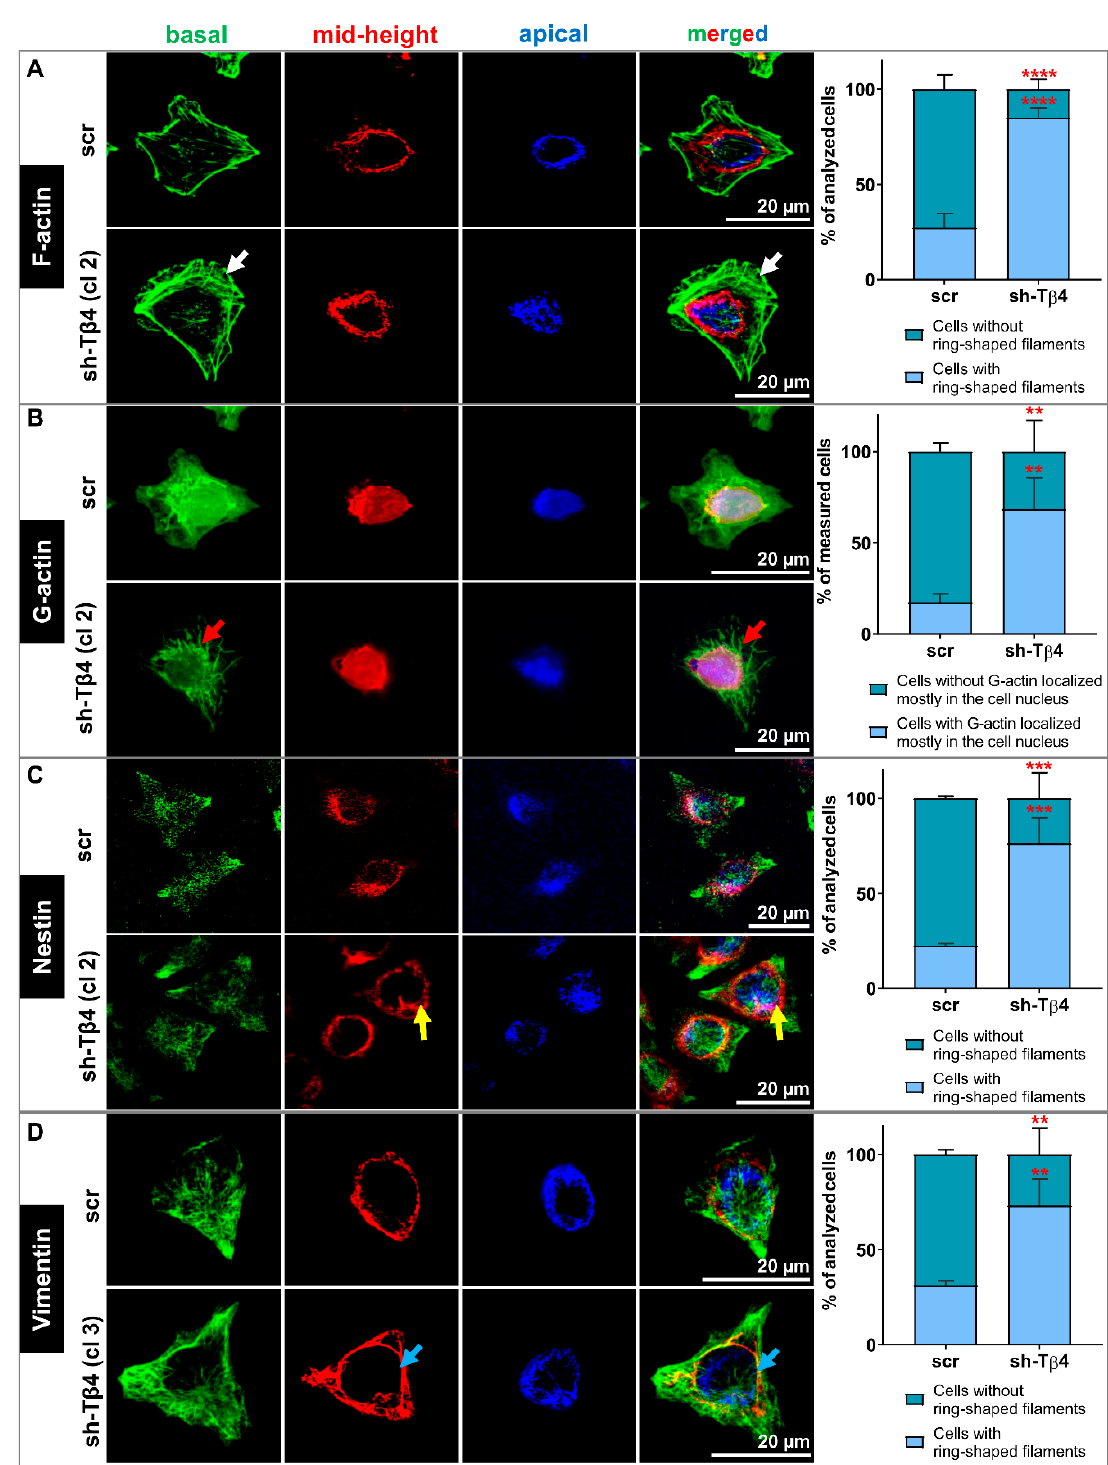
Figure 6. The role of T β 4 in the actin cytoskeleton and organization of Nestin and Vimentin filaments in scr and sh-T β 4 cells. ( A – D ) Immunocytochemical stainings to detect selected cytoskeleton components in scr and shT β 4 cells. The confocal microphotographs pictures for each cell were captured at three focal planes: cell contact area to the substratum (basal—green), a cross-section of the cell nucleus (mid-height—red), and nucleus apical outer surface (apical—blue). Finally, the photos were merged into a single image. ( A ) Detection of filamentous actin (F-actin). White arrows indicate stress fibers. ( B ) Visualization of monomeric actin (G-actin). Red arrows indicate the denser aggregation of G-actin in the cytoplasm. ( C ) Detection of subcellular localization of Nestin. Yellow arrows indicate a ring-shaped localization around the nucleus. ( D ) Immunocytochemical staining to detect Vimentin. Blue arrows indicate a ring-shaped structure around the nucleus. Separated microphotographs with additional visualization of F-actin and cell nucleus are presented in Supplementary